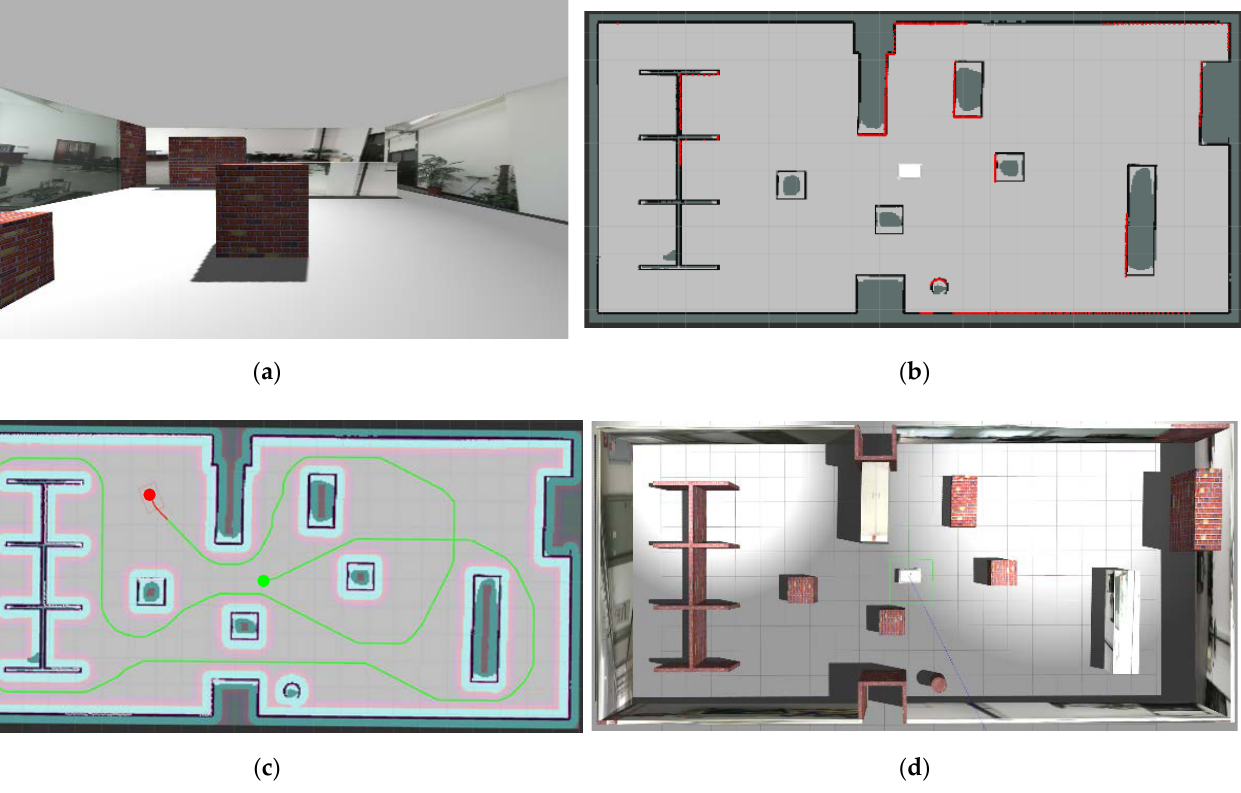
Figure 6. ( a ) Obtained image information; ( b ) Laser measurement information; ( c ) The robot’s tra- jectory; ( d ) Simulation environment in